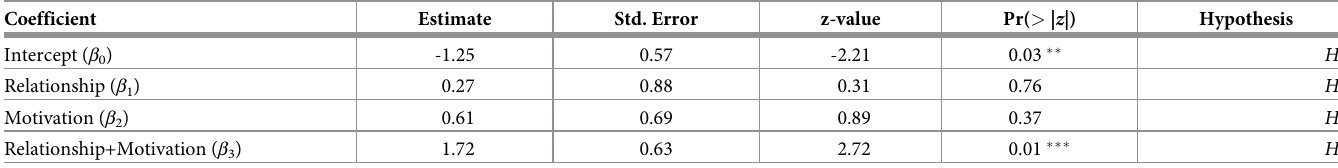
Table 4. Summary of generalized linear model of indirect cyber abuse using a single factor with four levels (Eq 11).